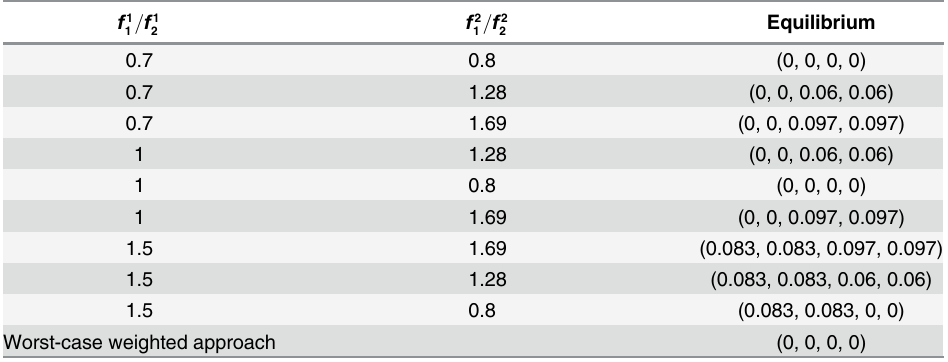
Table 1. Numerical test